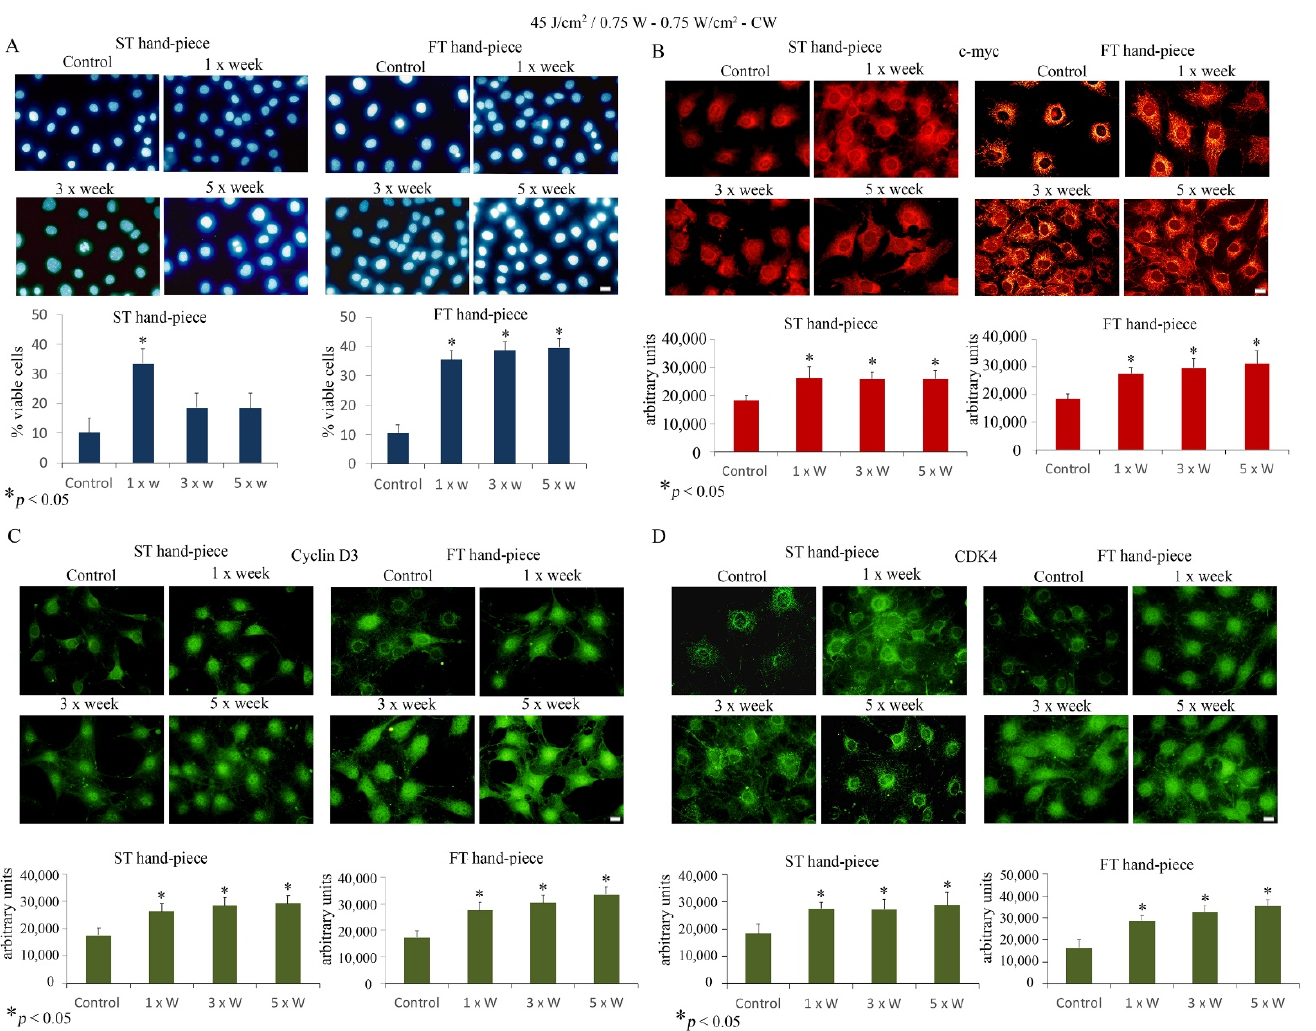
Figure 2. Effect of 45 J/cm 2 –0.75 W laser treatment on pre-osteoblast proliferation. The frequency of irradiation was once per week (1 × Week), three times (alternate day, 3 × Week), and five times (every day, 5 × Week). ( A ). The Hoechst stain assay revealed increased cell viability using both standard (ST) and flat-top (FT) hand-pieces. Notably, the FT device has managed to yet again increase the efficacy of the laser treatment at all time points applied (values represent means ± S.E., p < 0.05 compared to the control). ( B – D ). Single immunolabeling for c-myc ( B ) cyclin D3 ( C ) and CDK4 ( D ). The Fluorescence analysis was quantified by a Tecan Infinite fluorescence reader and values were analyzed by Magellan v4.0 software. Asterisks show the statistically significant differences of the samples analyzed compared with the control counterpart. Values represent means ± S.E; * p < 0.05 ( n = 4). Bar, 10 µm.